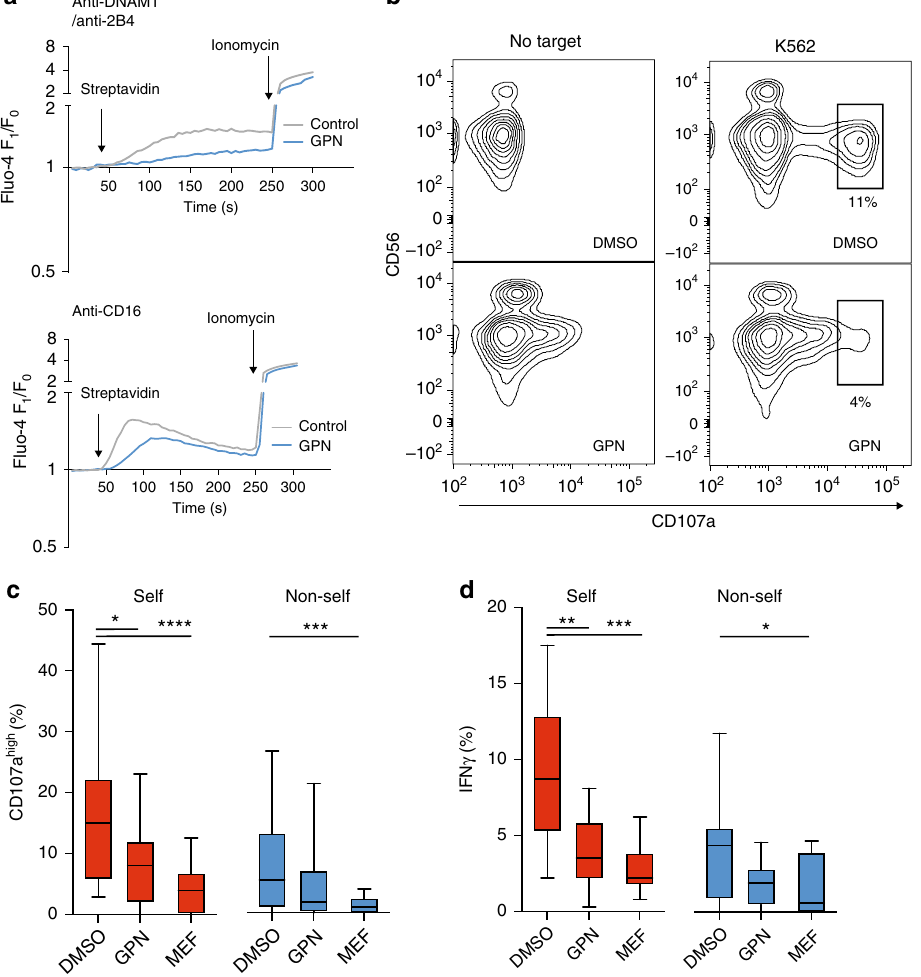
Fig. 5 Compromising lysosomal activity decreases NK cell function. a Global Ca 2 + - fl ux in resting bulk NK cells measured by Fluo-4 F 1 / F 0 ratio following stimulation with biotinylated anti-DNAM-1/anti-2B4 (top) or biotinylated anti-CD16 (bottom) crosslinked at the indicated time-point with streptavidin in the presence (added at the onset of stimulation and maintained throughout the assay) or absence of 50 μ M GPN. b Representative example of CD107a expression following stimulation of NK cells with K562 cells in the presence or absence of GPN. c Frequency of CD107 high + and d IFN γ + self-KIR + and non- self-KIR + NK cells following stimulation with K562 cells in the presence or absence of 50 μ M GPN or 10 μ M Me fl oquine (MEF). Friedman ’ s tests were performed followed by Dunn ’ s multicomparison tests. Whiskers show 5th to 95th percentile. Bars show the median. **** p < 0.0001; *** p < 0.001; ** p < 0.01; and * p < 0.05. Red and blue box plots represent NK cells with self or non-self KIR,